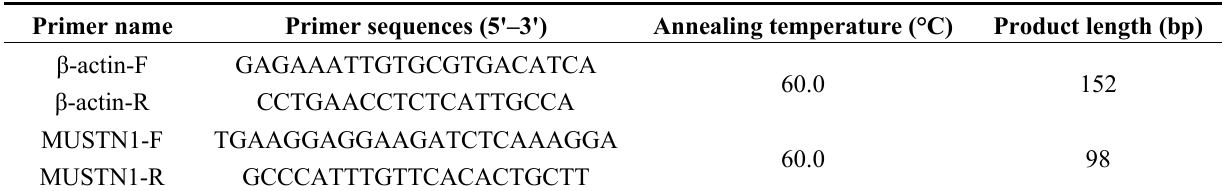
Table 5. Primer pairs for real-time quantitative PCR